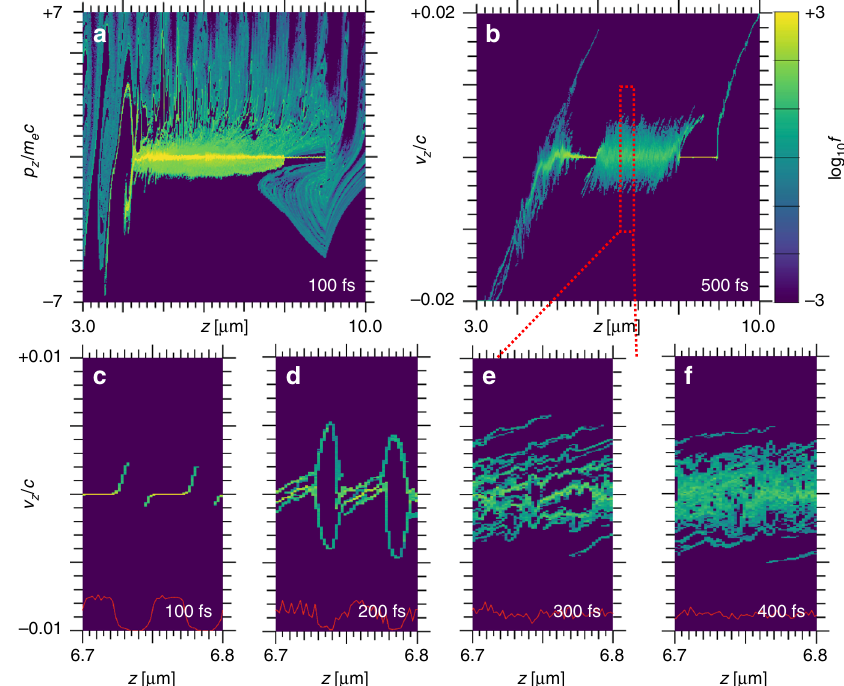
Fig. 2 Details of the foam expansion. One-dimensional particle-in-cell simulation of an intense laser pulse irradiating an encapsulated nanofoam target. Laser comes from z = 0, foam located at 6 – 8 μ m; shown are a electron velocity phase space at 100 fs; b ion velocity phase space at 500 fs; details of ion phase space in foam at c – f 100 – 400 fs